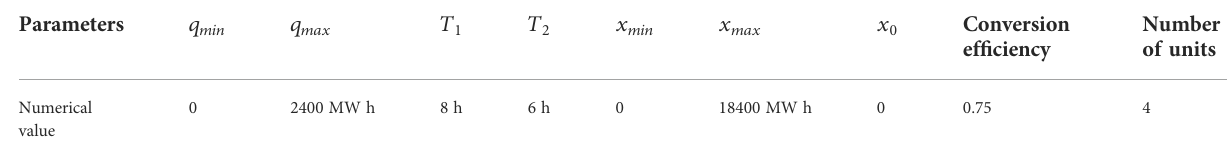
TABLE 1 Actual parameters of